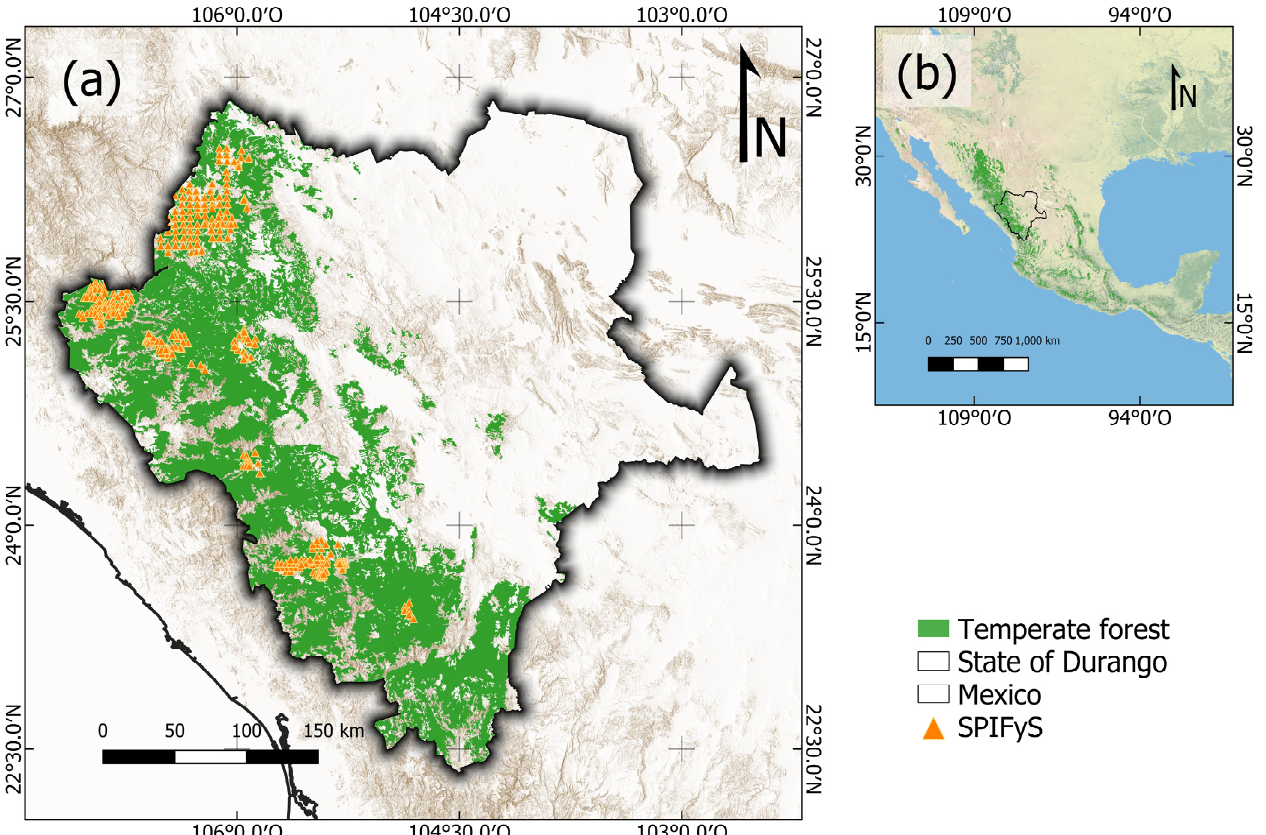
Figure 1. Study area. ( a ) Permanent forest and soil research sites (SPIFyS in Spanish). Temperate forest polygon taken from Land ‐ Used Map Series VI, which was developed by the Instituto Nacional de Estadística y Geografía (INEGI). ( b ) Location of study area.